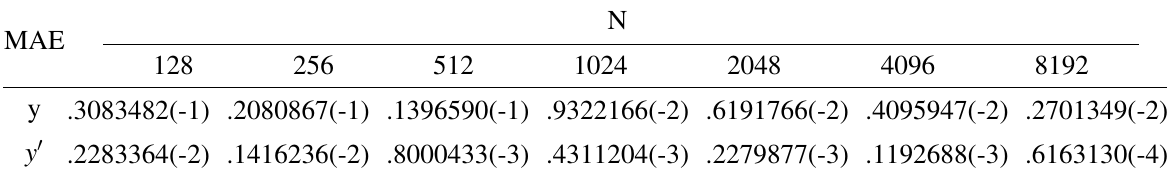
) and y (cid:48) ( x ) for Example 5.4 2